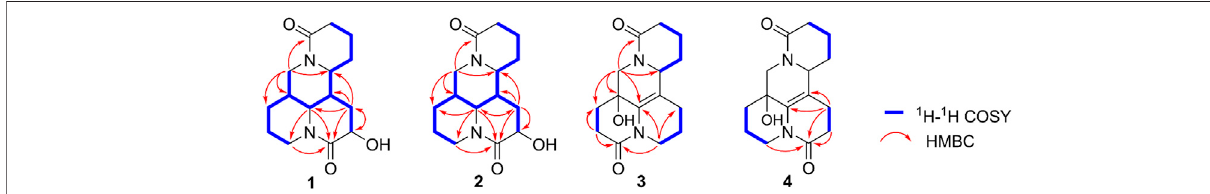
FIGURE 2 | Key 1 H − 1 H COSY and HMBC correlations of 1 – 4.